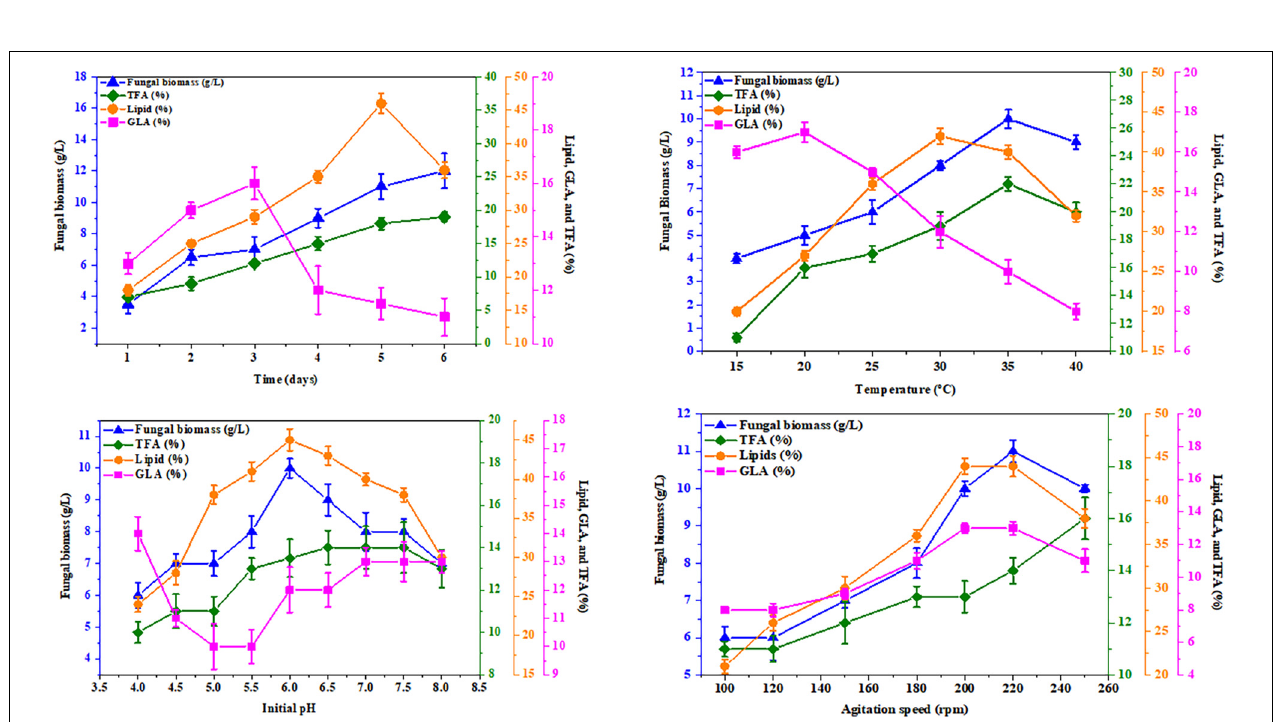
FIGURE 9 | Effect of fermentation time, temperature, initial pH, and agitation speed on the biomass, total lipids, GLA content, and TFAs in R. pusillus AUMC 11616.A. Asparagine amino acid was employed as the nitrogen source. Error bars represent the average standard deviations of three biological replicates.